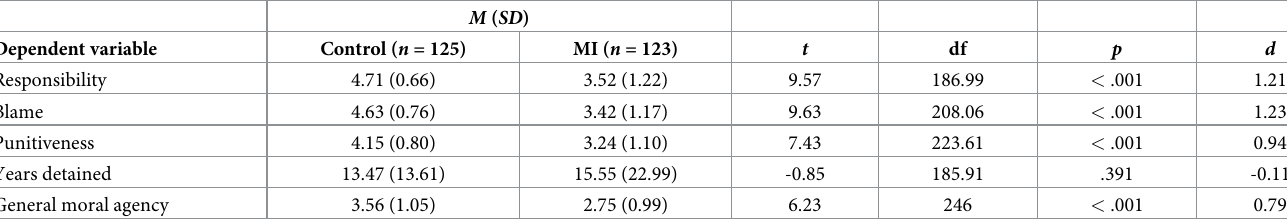
Table 4. Descriptive and t-test statistics for dependent variables at trial (Study 2).